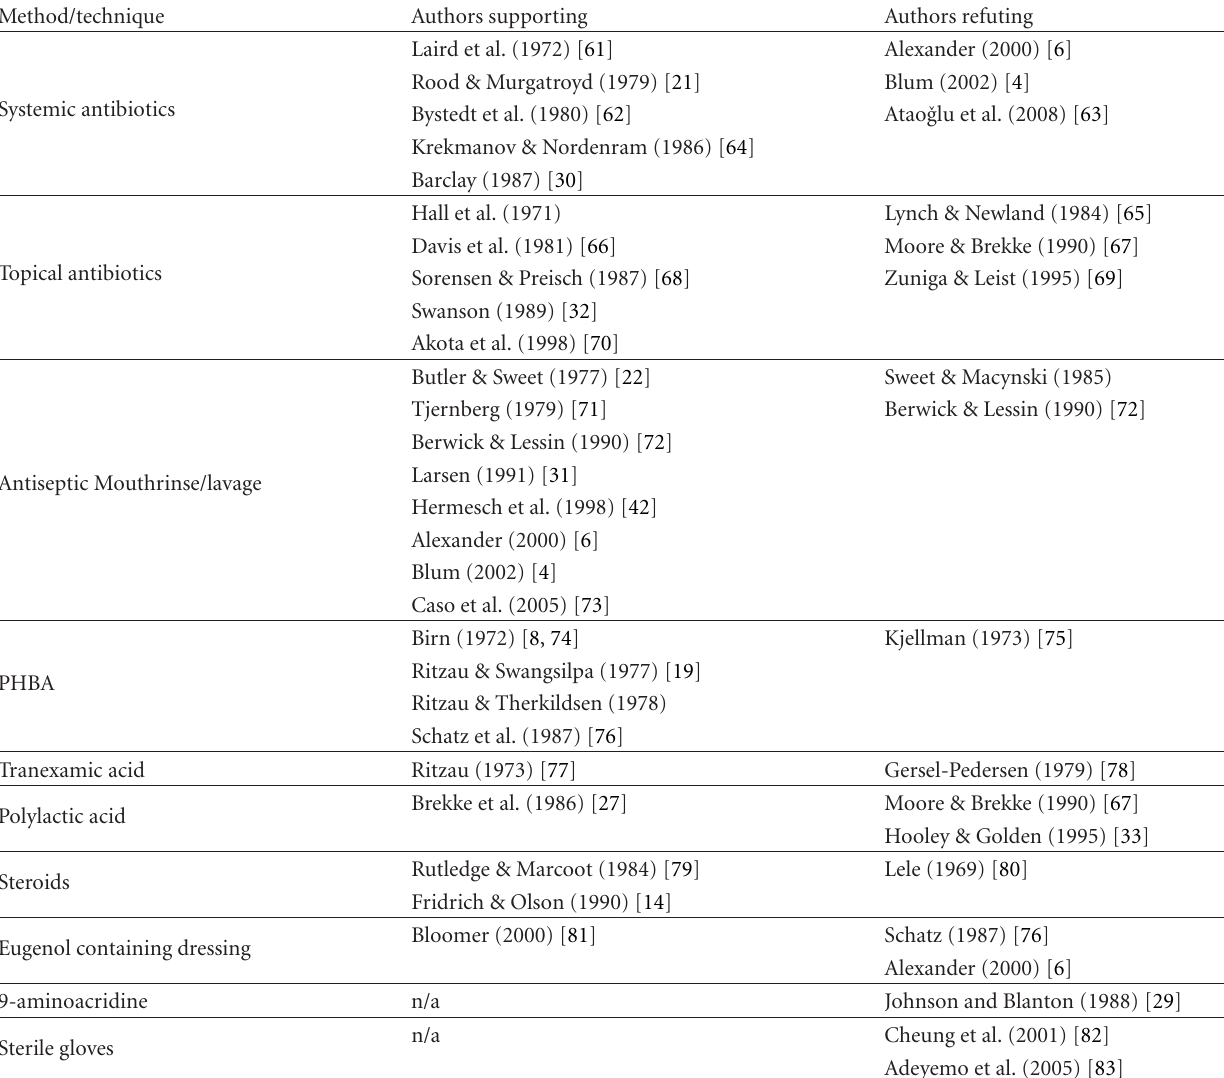
Table 2: Proposed techniques for decreasing risk for development of AO and related